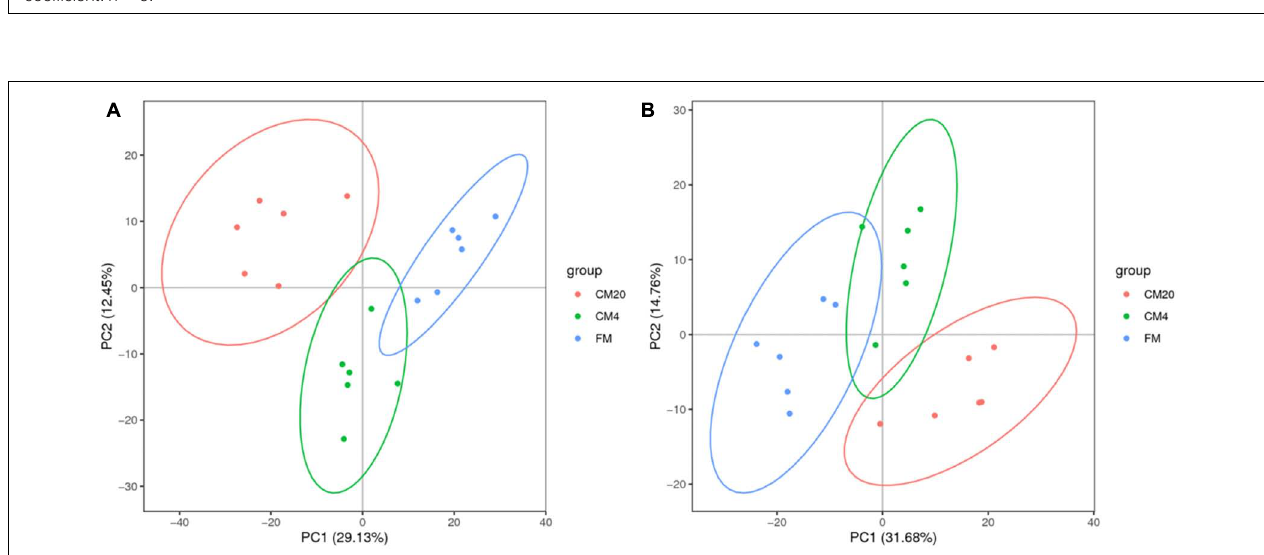
FIGURE 5 | The results of the total PLS-DA score plots from the UPLC-MS spectra of the distal intestinal contents in positive (A) and negative (B) modes. Blue dots represent the FM group (fishmeal group-control); green dots represent the CM4 groups [4% CM (castor meal) protein replacement to FM protein]; red dots represent CM20 groups (20% CM protein replacement to FM protein). n =